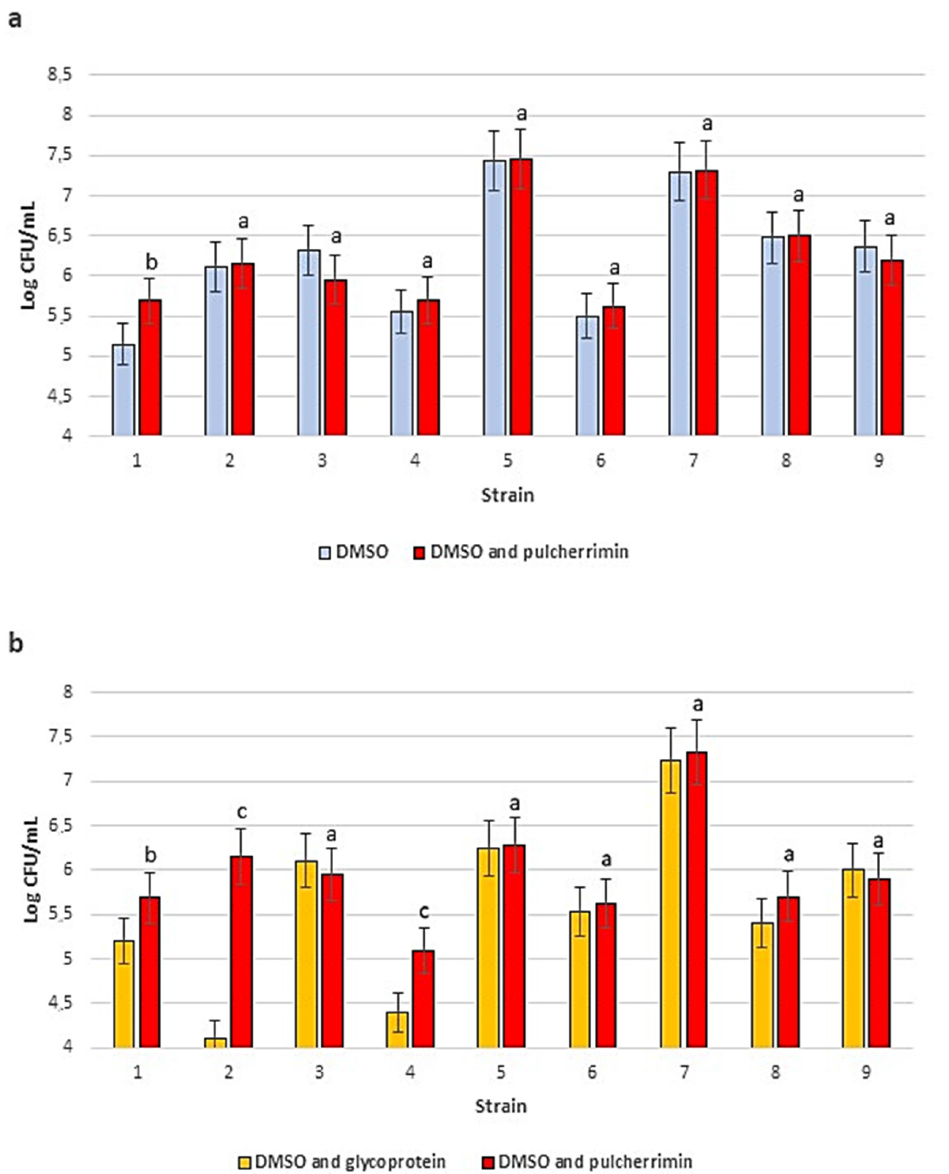
Figure 6. Comparison of the number of viable yeast cells after 6 months of storage at − 196 °C in the presence of different cryoprotectants: DMSO (control) and DMSO with pulcherrimin ( a ); DMSO with glycoprotein (control) and DMSO with pulcherrimin ( b ). Yeast strains: 1— C. macerans CCY 10-1-17; 2— G. candidum CCY 16-1-25; 3— P. flavescens CCY 17-3-34; 4— S. metaroseus CCY 19-6-22; 5— R. dairenensis CCY 20-2-25; 6— F. capsuligenum CCY 29-143-1; 7— C. zemplinina CCY 20-178-1; 8— A. porosum CCY 30-18-5; 9— S. pombe CCY 44-1-3. Values with different letters are statistically different: a : p ≥ 0.05; b : 0.005 < p < 0.05; c : p < 0.005.